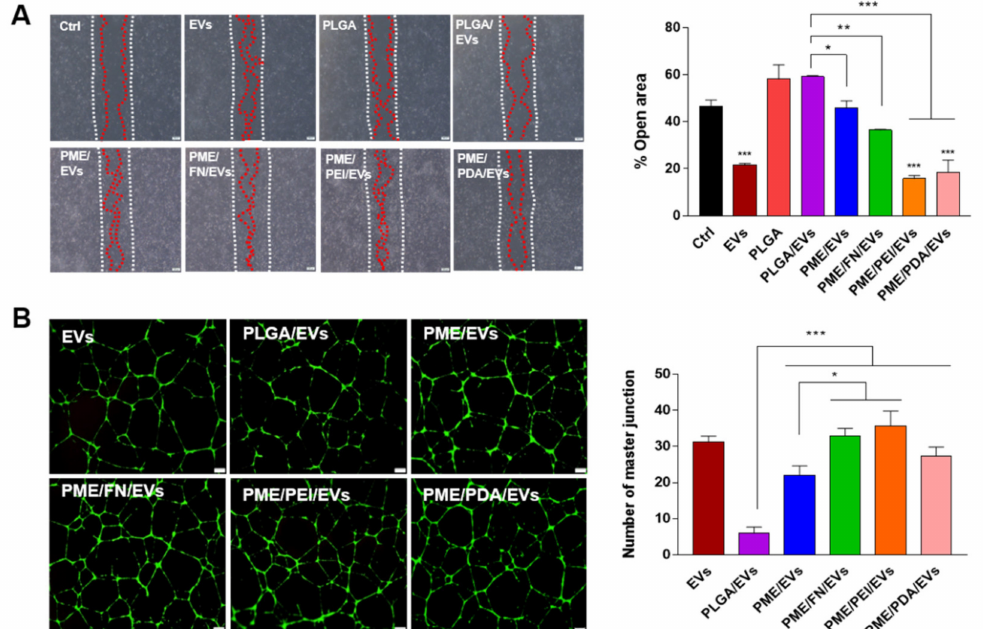
Figure 4. Effect of EVs released from the composite films on angiogenesis. ( A ) Representative images and quantitative analysis of wound healing assay. ( B ) Representative images and quantitative analysis of tube formation assay characterizing number of master junction. Scale bars = 200 µ m. The data are expressed as mean ± SD ( n = 3). * p < 0.05; ** p < 0.01; *** p <